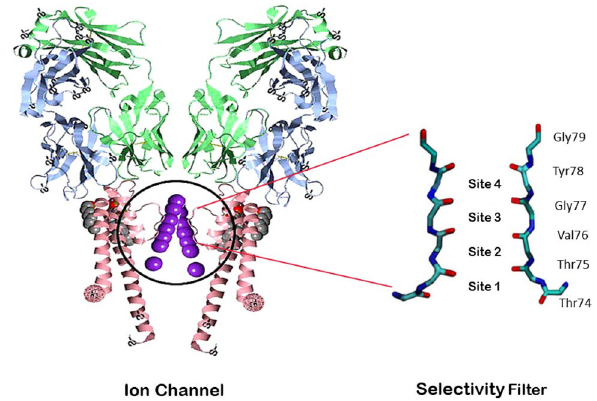
Figure 1. (Left) A representation of KcsA ion channel after PDB 1K4C. (Right) Two P-loop monomers in the selectivity